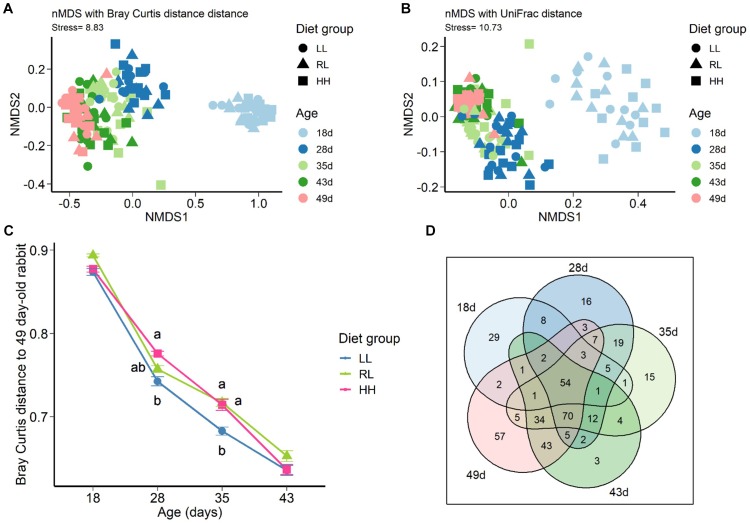
Non-Metric Dimensional Scaling (nMDS) two-dimensional representation of cecal bacterial community using Bray Curtis (A) and Unifrac distances (B) of rabbits in groups LL, RL, and HH from 18 to 49 days of age. Maturity of cecal bacterial community (C) the higher the value, the greater the dissimilarity of the bacterial community is from 49 days; means with different superscript differ at P < 0.05. Venn diagram (D): occurrence of the OTUs across the cecal ecosystems from 18 to 49-day-old. The OTUs detected in at least 75% of the samples of the same age group were conserved.